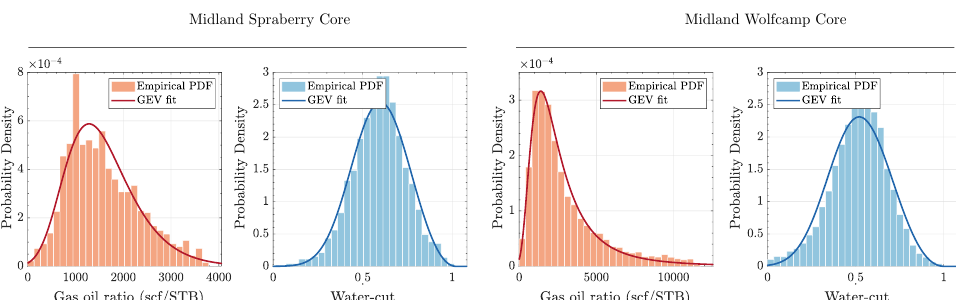
Figure 7. Example of the GEV means of gas oil ratios and water-cuts in the Midland Spraberry Core and the Midland Wolfcamp wells.